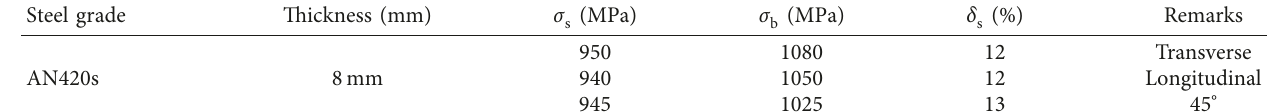
Table 1: Mechanical properties of AN420s-grade steel